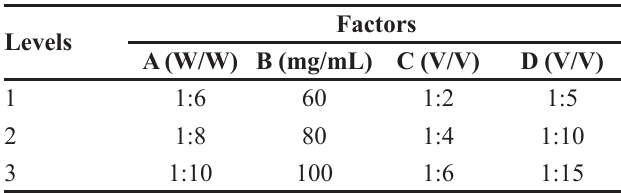
TABLE I - Factors and levels of the orthogonal experimental